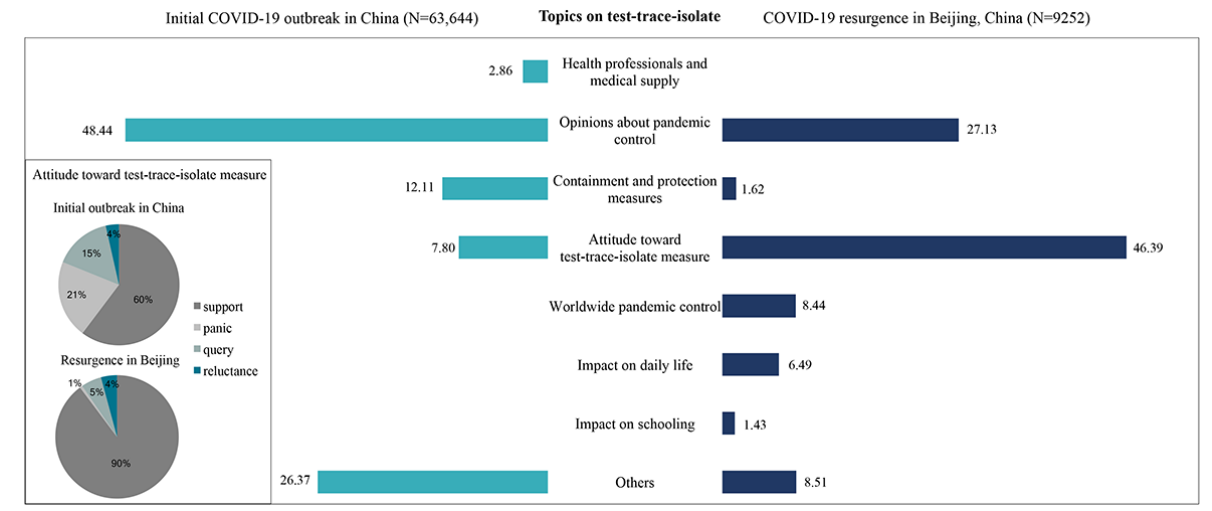
Figure 5. Proportion of posts related to frequently discussed topics on the test-trace-isolate measure during the initial outbreak and the resurgence of COVID-19 in China. The columns show the proportion of posts on each topic among all posts related to the test-trace-isolate measure. Pie charts show the proportion of various attitudes toward the test-trace-isolate measure between the initial outbreak and resurgence.